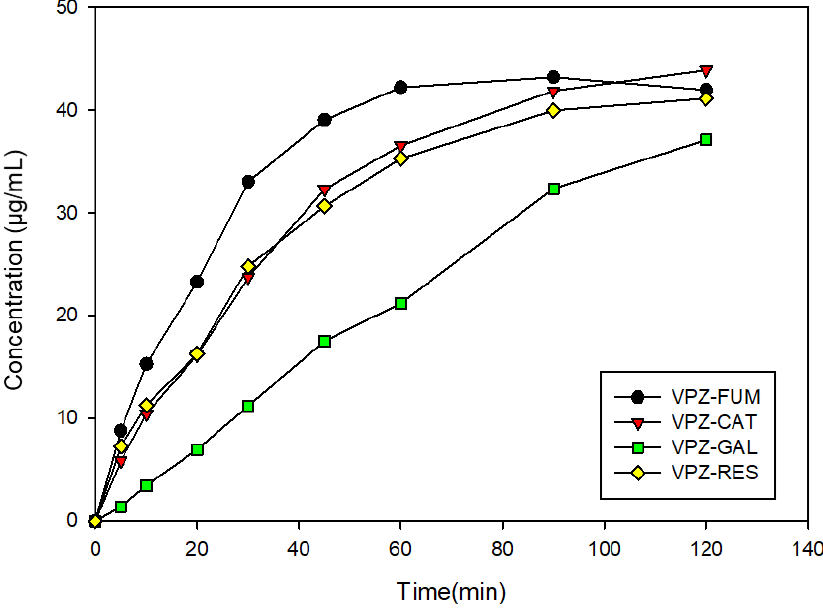
Figure 8. IDR curves of 3 VPZ cocrystals and VPZ fumarate at pH 6.8 in buffer solution.